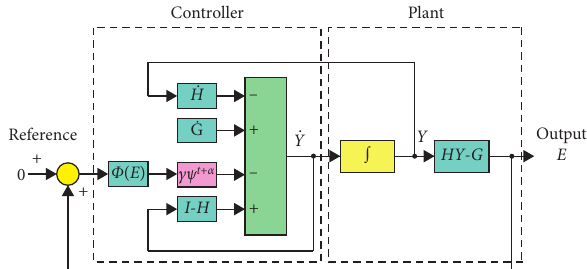
Figure 2: The realization process of model (23) for solving the repeated motion planning of the mobile